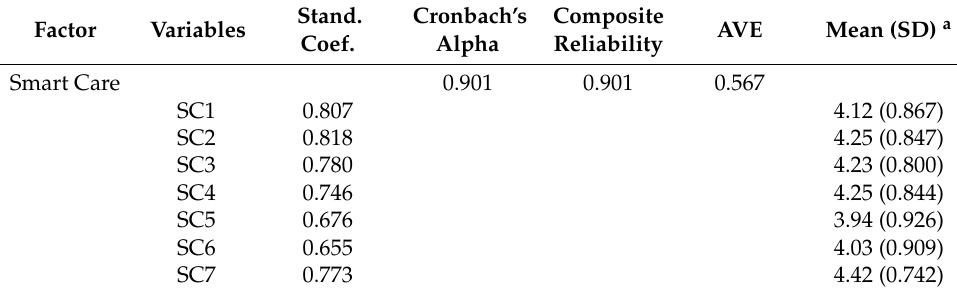
Figure 3. Confirmatory Factor Analysis (EFA). Maximum Likelihood Procedure. Table 5. Scale Items and Confirmatory Factor Analysis result (n =